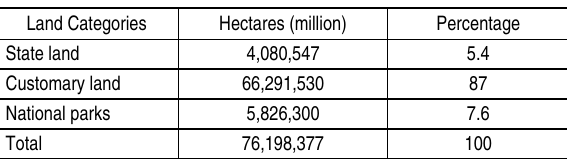
Table 1. Areas of land under different tenure catego- ries